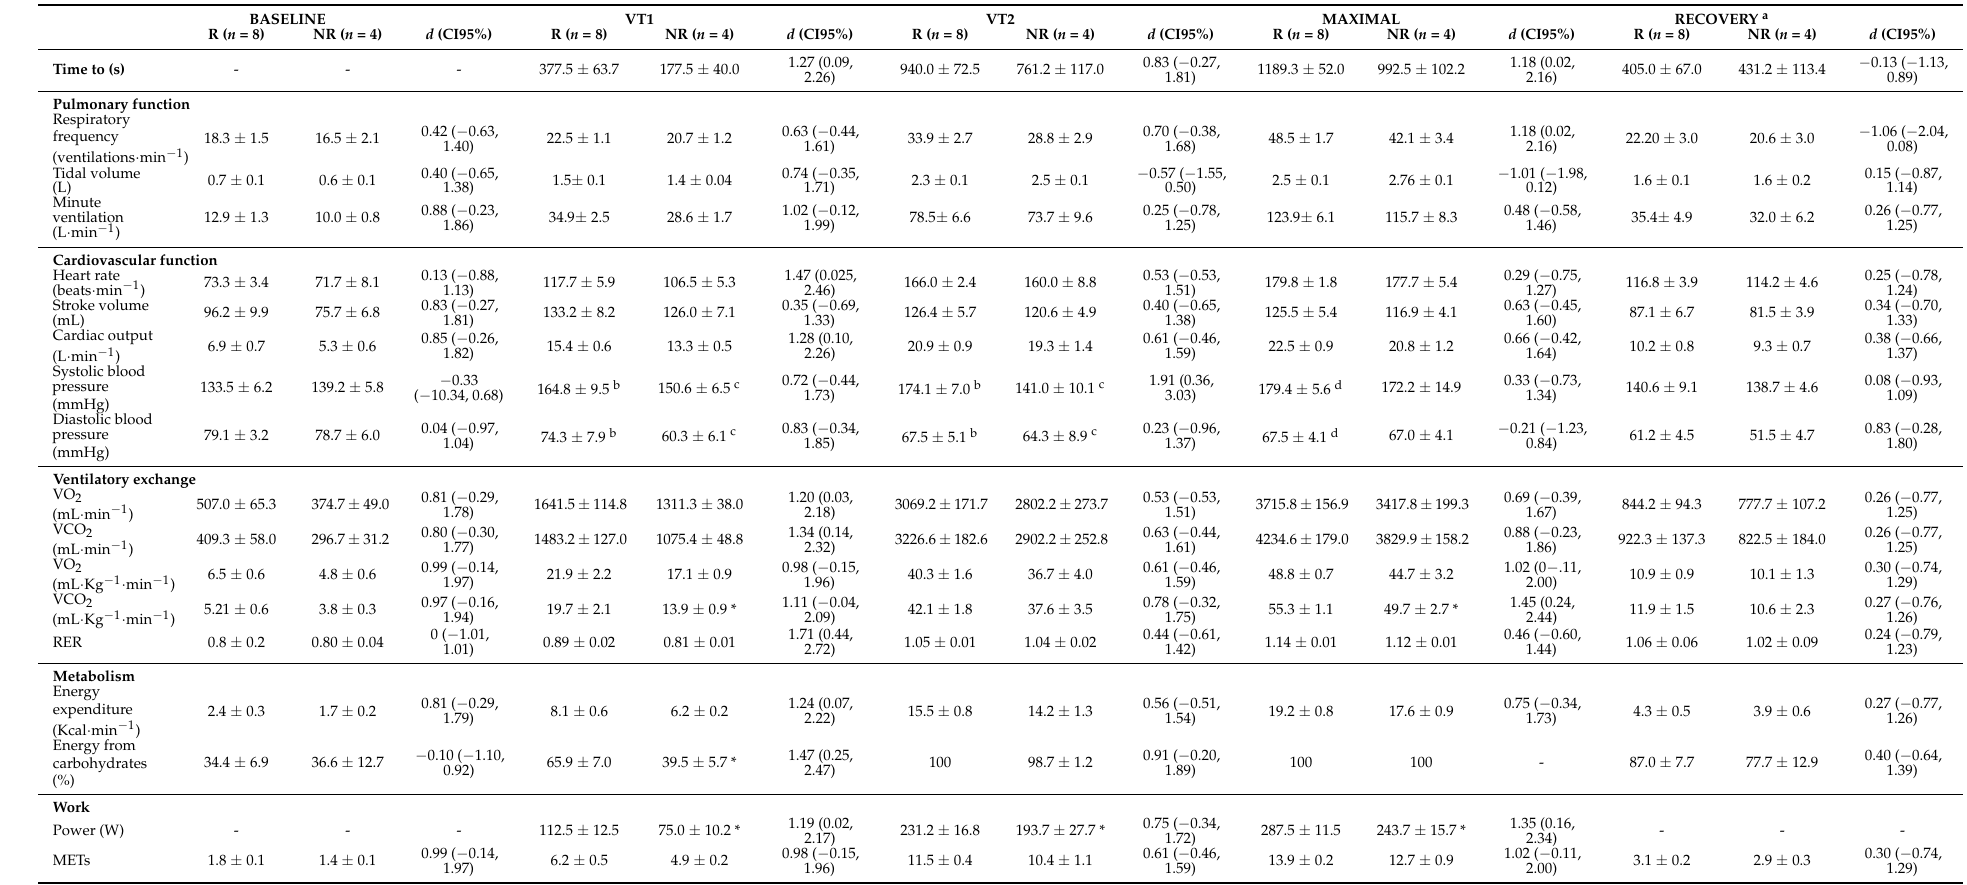
Table 2. Metabolic and cardiorespiratory responses along the graded exercise